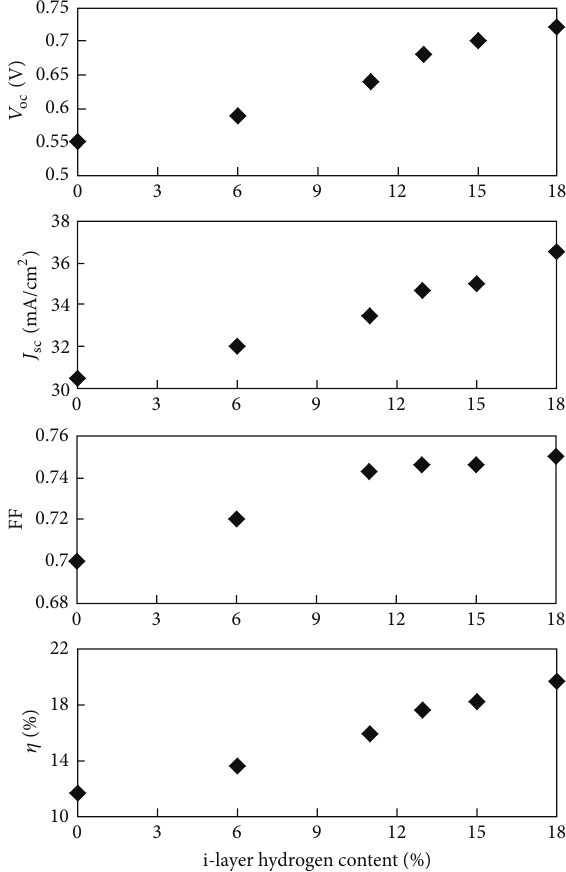
Figure 2: Simulation results of the performances of HJ solar cells as a function of the i-layer hydrogen